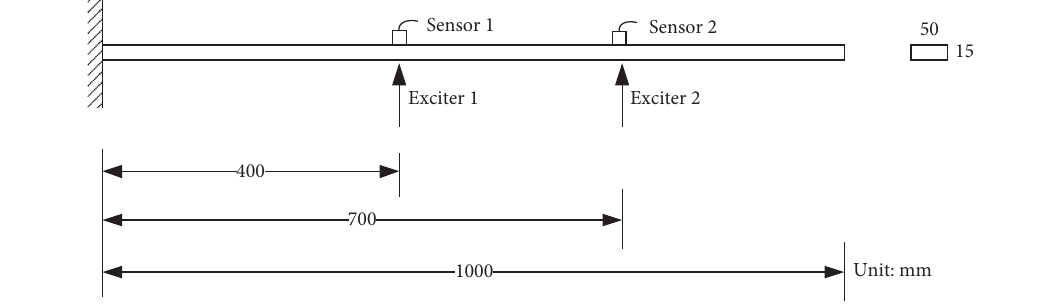
Figure 5: Cantilever beam used in simulation. Table 2: Reference spectrum at control point 1.